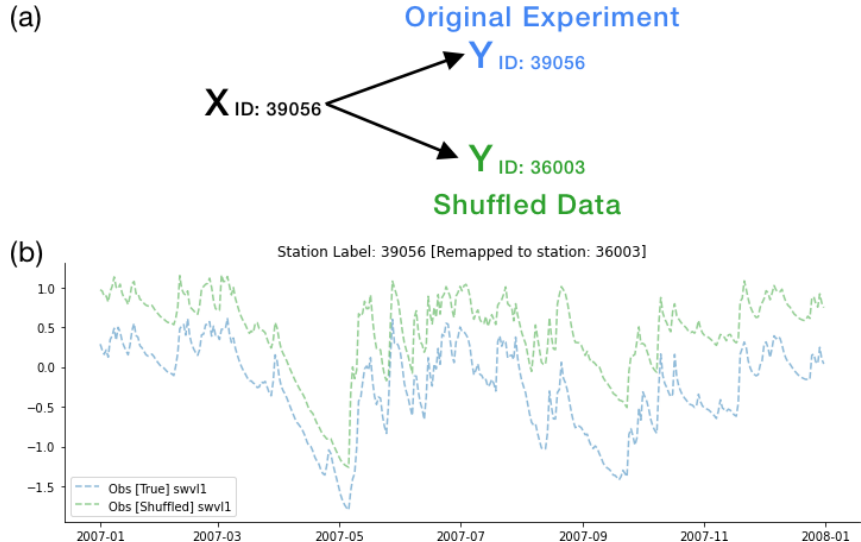
Figure A1. (a) Conceptual diagram explaining spatial shuffling. In the original experiment, c t from Gauge ID 39056 is linked to the time series for that Catchment 39056. The shuffled target instead asks the probe to detect the target variable time series (belonging to Gauge ID 36003) using the c t vector from Gauge ID 39056. (b) Example time series from shuffled basins, where Station 39056 is the original experiment and Station 36003 is the shuffled experiment. It is worth noting that the soil moisture measurements are highly correlated in space (shown by the blue and green lines following each other), and in some instances multiple basins may fall within the same ERA5-Land pixel, in which case the information content will be the same.